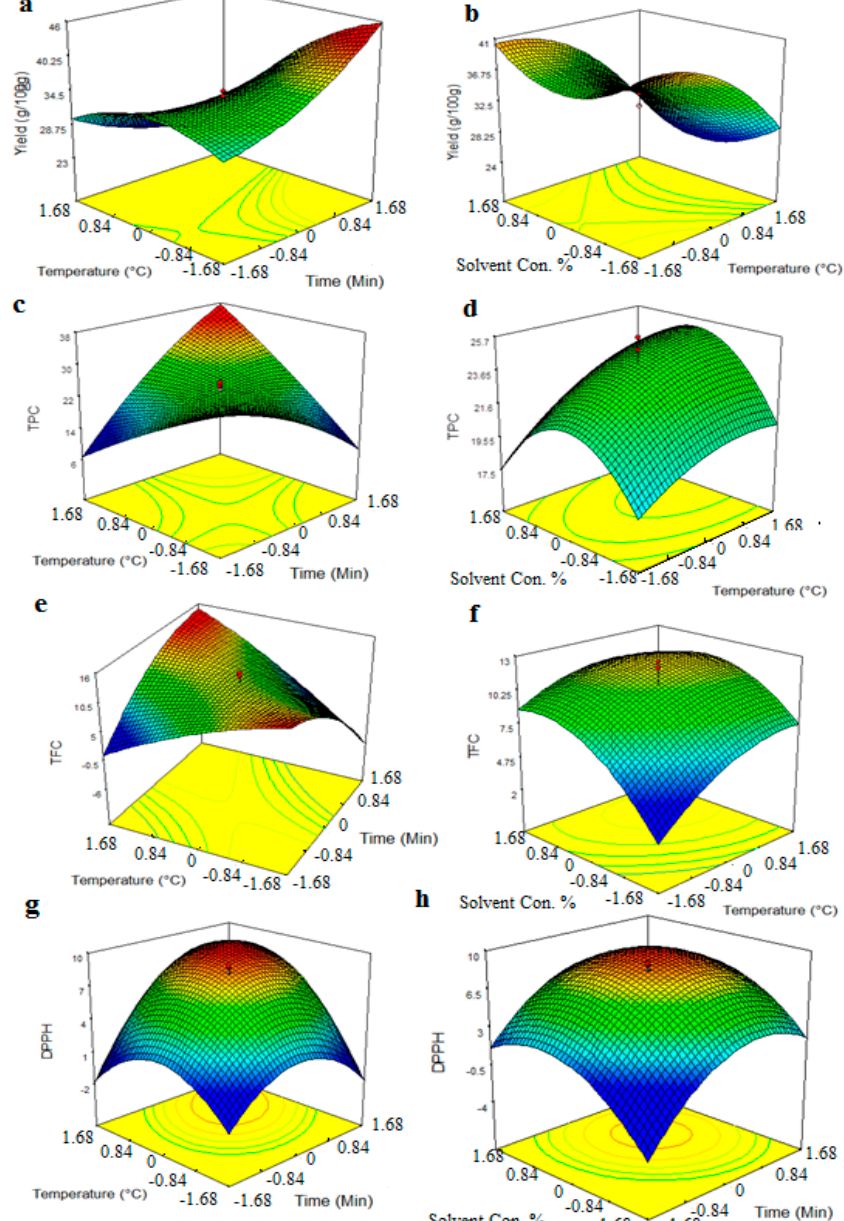
Figure 1. Response surface graph for the optimization of ( a ) extract yield (g/100 g) versus time (min) and temperature (°C) of extraction; ( b ) extract yield (g/100 g) versus temperature (°C) and solvent concentration (%); ( c ) TPC mg GAE/g versus time (min) and temperature (°C) of extraction ( d ) TPC mg GAE/g versus temperature (°C) and solvent concentration (%) of extraction; ( e ) TFC (QEQ/g) versus time (min) and temperature (°C) of extraction; ( f ) TFC (QEQ/g) versus temperature (°C) and solvent concentration (%); ( g ) Antioxidant activity versus time (min) and temperature (°C) of extraction; ( h ) Antioxidant activity versus time (min) and solvent concentration (%).